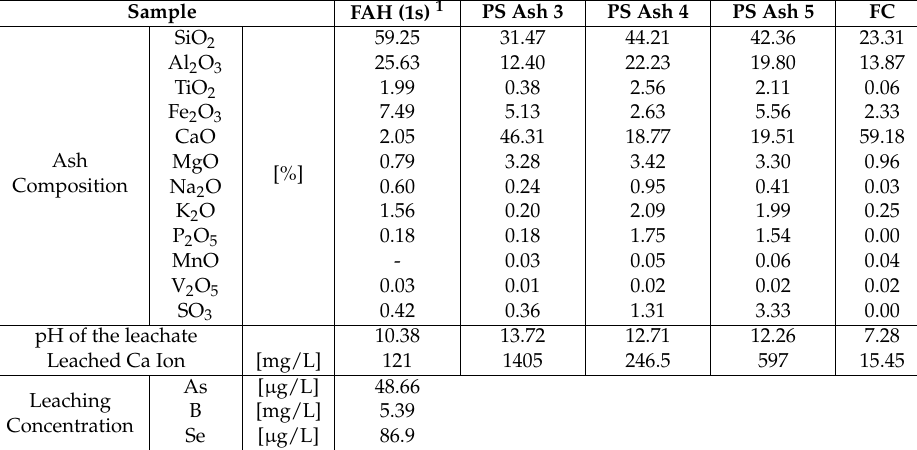
Table 1. Composition of inorganic elements in fly ash and